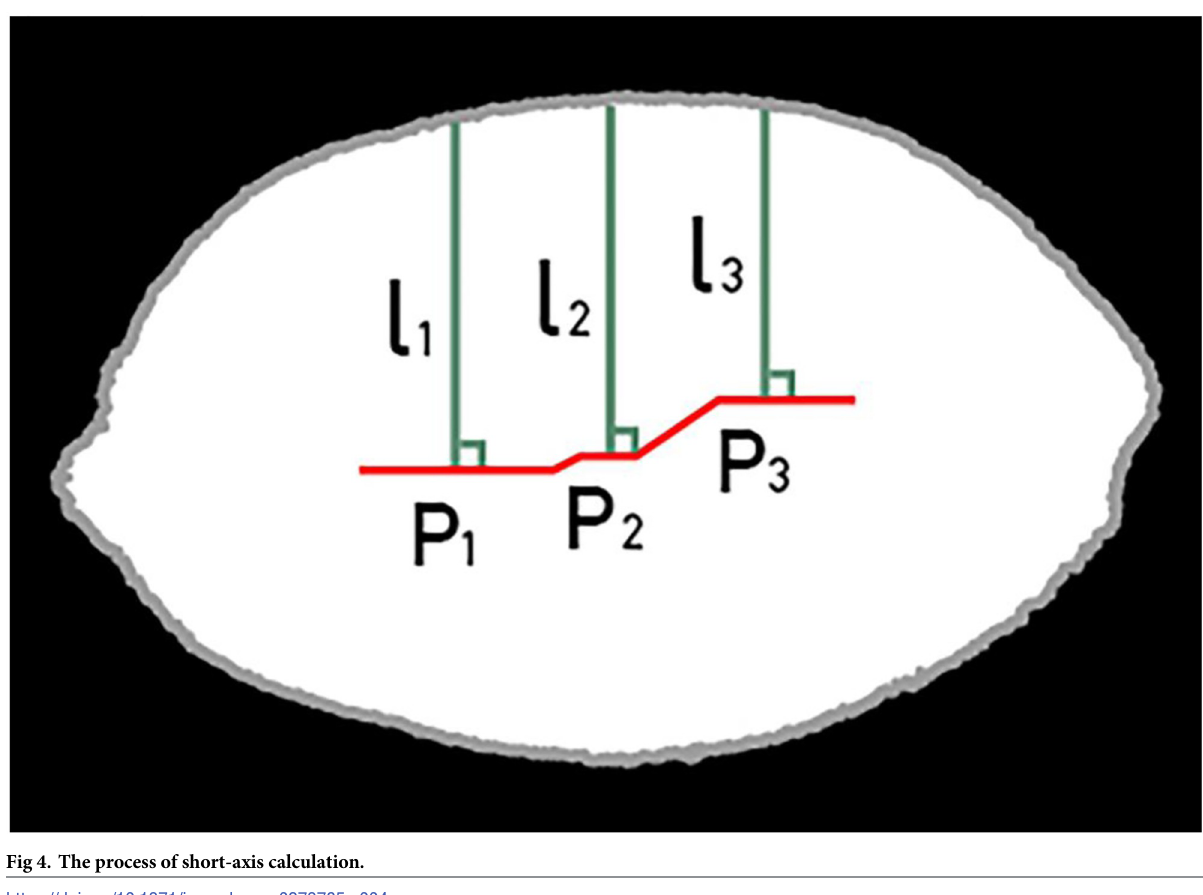
Fig 4. The process of short-axis calculation.